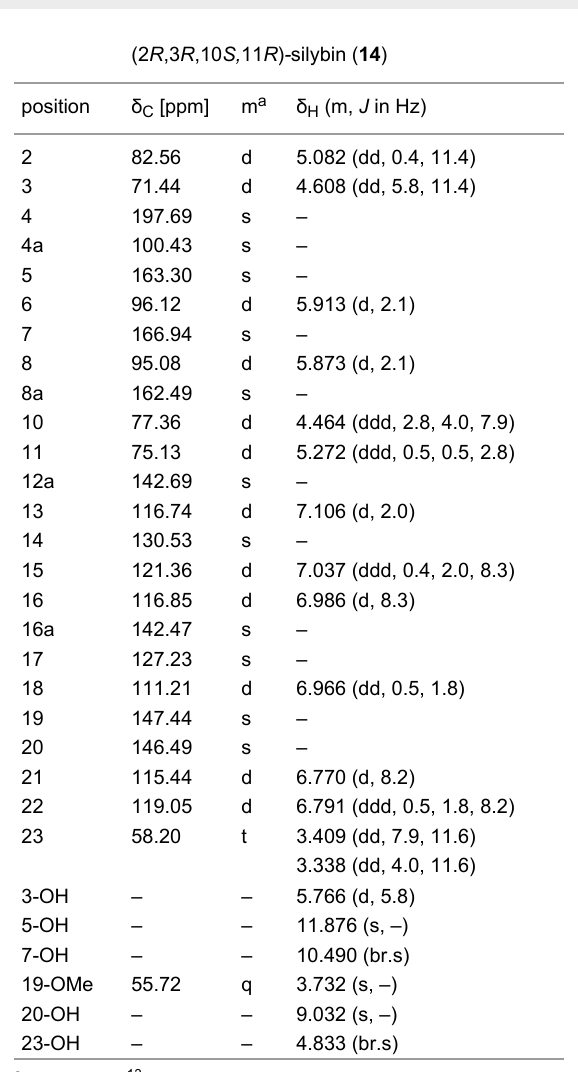
Table 8: NMR spectroscopic data (600 MHz, DMSO- d 6 , 30 °C) of compound 14